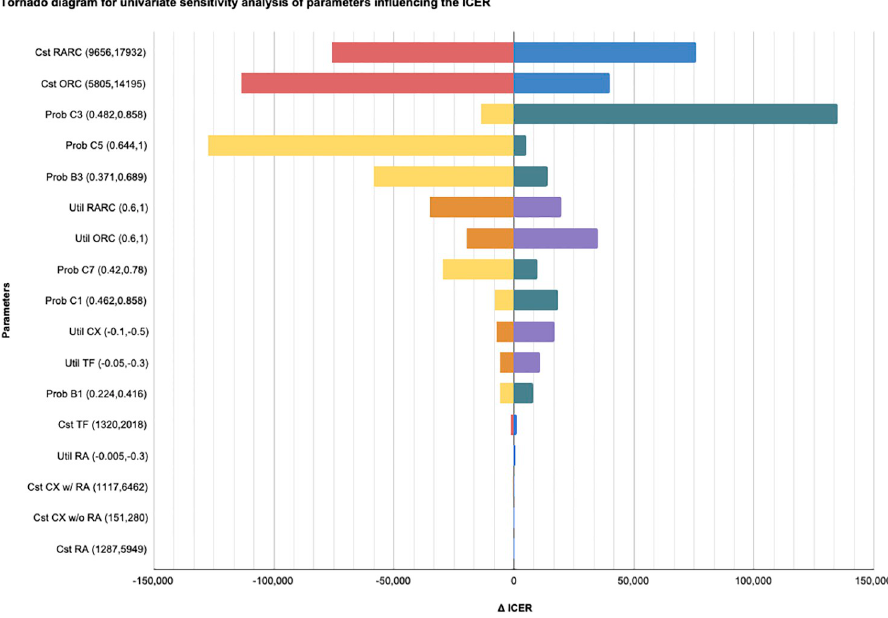
Fig 6. Tornado diagram representing impact on the ICER when varying one parameter (univariate sensitivity analysis). Abbreviations: Prob = probabilities; Cst = costs; Util = utilities; TF = transfusion; CX = complications; RA = readmission; w = with; w/o =